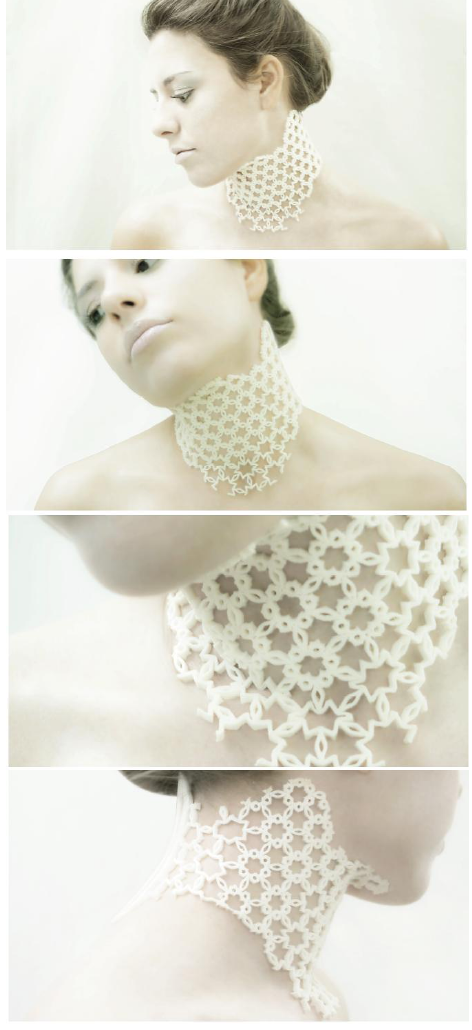
Figure 22. Adaptation of the neckbrace to body